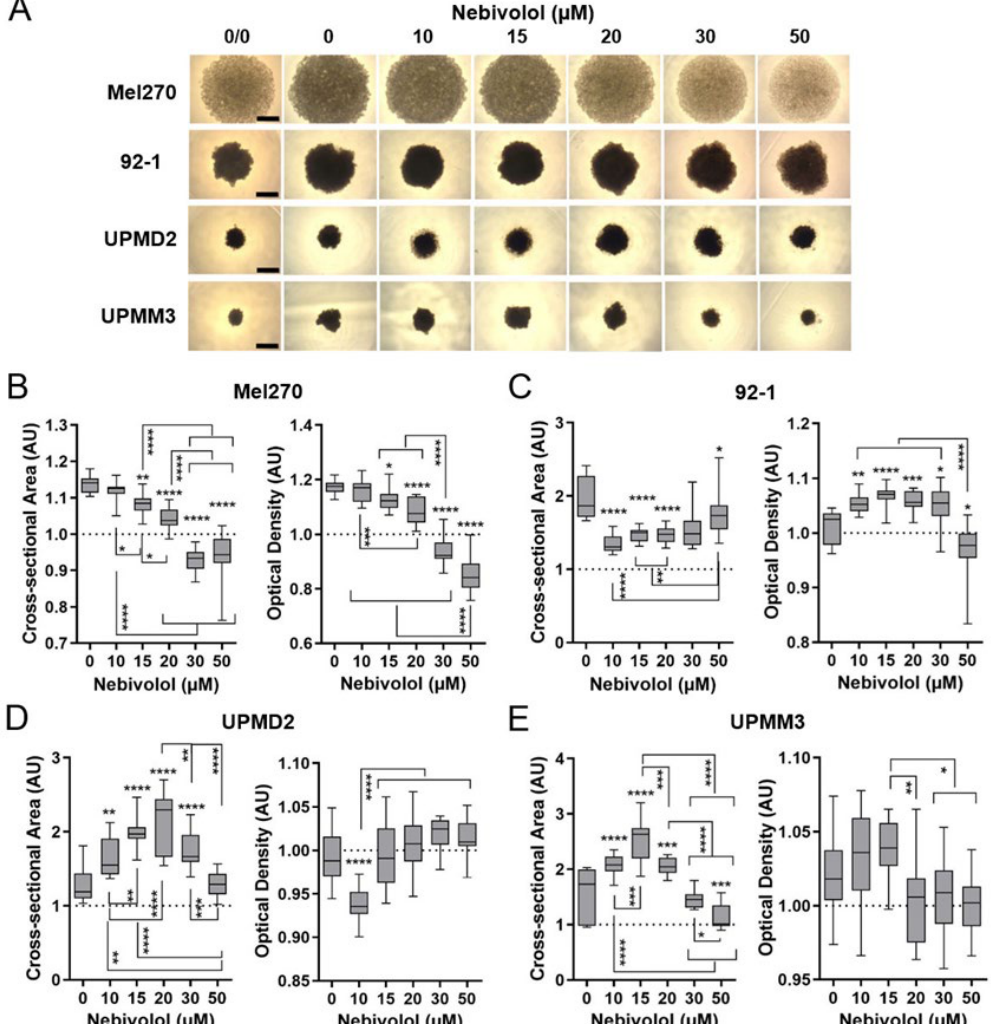
Figure 3. Morphology changes of 3D UM tumor spheroid types by nebivolol treatment. Mel270, 92-1, UPMD2, or UPMM3 derived spheroids were incubated with nebivolol at the indicated concentrations for 7 days. The spheroids were microscopically imaged before and after treatment, and cross-sectional area and density were measured. ( A ) Representative microscopic images of the spheroids treated with 0 – 50 µM nebivolol; untreated spheroids are marked 0/0. Spheroids were imaged at 4× magnification, scale bars indicate 500 µm. ( B – E ) Spheroid cross - sectional area and optical density of the respective spheroid types were determined and normalized to the respective spheroids before treatment (0/0). Box plots with min to max whiskers and a median of three independent experiments for each spheroid type with n = 5 spheroids each concentration shown. The means of the cross - sectional area or the optical density of the spheroids before treatment (0/0) are represented by dotted lines. A one - way ANOVA and Tukey’s multiple comparisons test were used for statistical analyses, significance levels are indicated at * p < 0.05, ** p < 0.01, *** p < 0.001, and **** p < 0.0001.